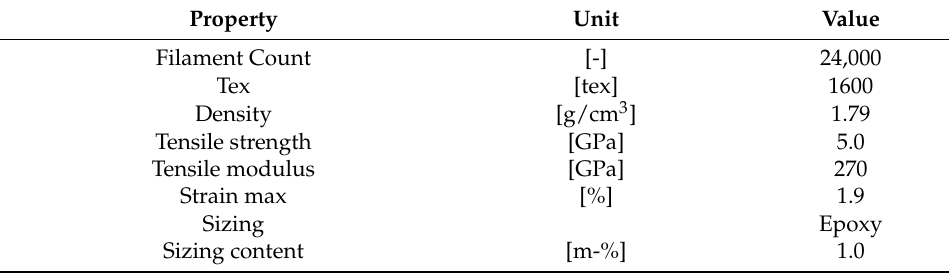
Table A1. Basic values of C-Fibre: SGL SIGRAFIL ® C T24-5.0/270-E100.